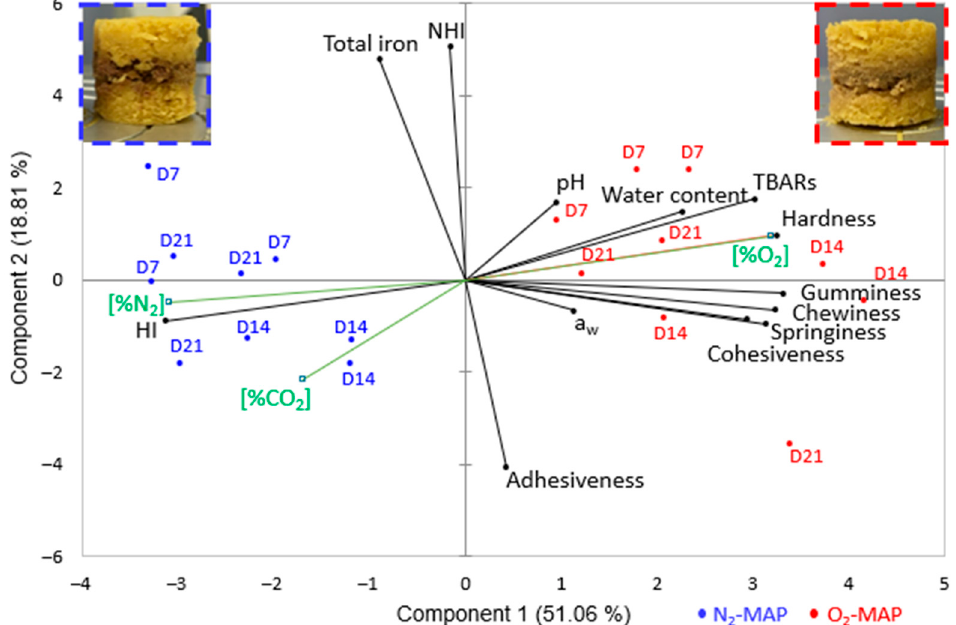
Figure 5. PCA map of 3D-printed form-C products showing the impact of time in storage and MAP conditions on physicochemical, nutritional and textural parameters. Black lines: principal variables; green lines: supplementary variables. Each trial is identified by time in storage (D7 to D21) and MAP (N 2 -MAP in blue; O 2 -MAP in red). Insets in the upper corners are representative of the samples obtained according to MAP conditions from day 7.